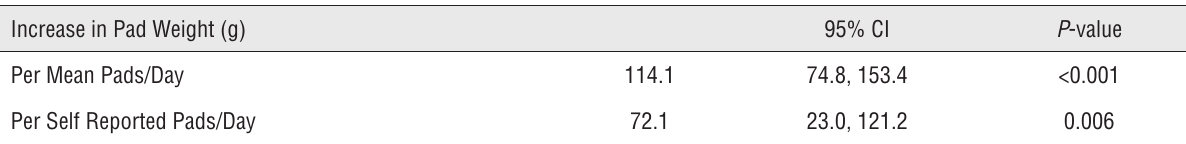
Table 3 - Association of Mean pad weight & Mean number of pads.